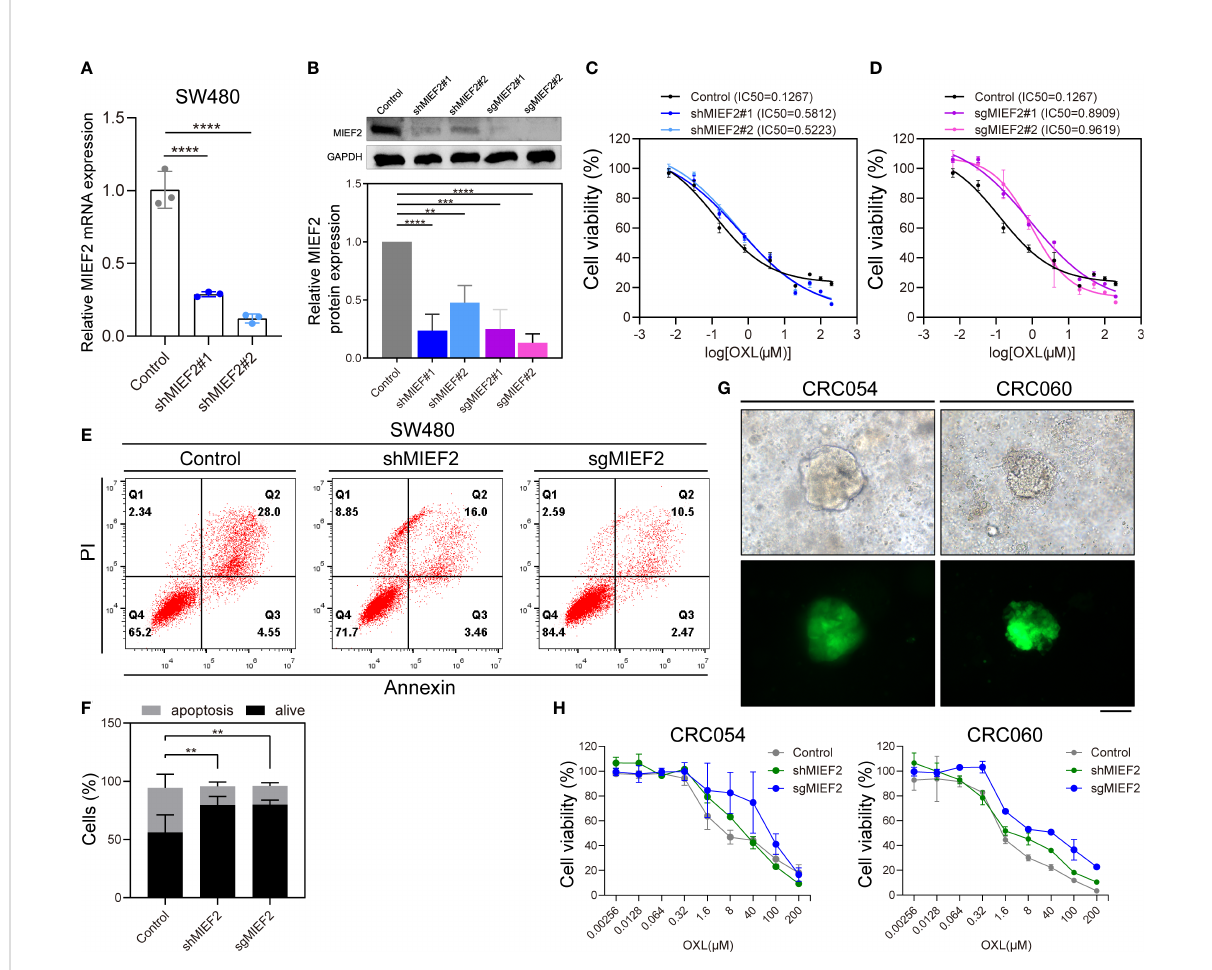
FIGURE 4 Loss of MIEF1 increases the resistance of CRC cells to OXL. (A, B) qPCR and western blotting to show the knockdown ef fi ciency of shRNA and sgRNA targeting MIEF2 (shMIEF2 and sgMIEF2) in SW480. Bar plots show MIEF2 expression between different groups. Statistical analysis was performed using two-tailed unpaired t-test. ** P <0.01, *** P <0.001, **** P <0.001 (mean ± SD, n = 3 repetitions). (C, D) OXL dose-response curves of non-targeted control, shMIEF2 and sgMIEF2 (black connected dots: control; blue connected dots: shMIEF2; purple connected dots: sgMIEF2). (E, F) Comparison of apoptosis induction in non-targeted control and MIEF2-de fi cient (shMIEF2 and sgMIEF2) SW480 cells after oxaliplatin treatment by fl ow cytometry analysis. Knockdown of MIEF2 signi fi cantly downregulates apoptosis after OXL treatment in SW480. Stacked plots show the percentage of apoptotic (AnnexinV+) and viable (AnnexinV − /PI − ) cells. Statistical analysis was performed using one-way ANOVA. ** P <0.01 (mean ± SD, n = 3). (G) Representative light microscopy and fl uorescence images of organoids following lentivirus infection. The green fl uorescence is carried by the vector, indicating successful lentiviral infection of the organoids. Black scale bars, 100 m m. (H) Dose- response curves of no-target control organoids (CRC054 and CRC060), shMIEF2 and sgMIEF2 to OXL (gray connected dots: control; green connected dots: shMIEF2; blue connected dots: